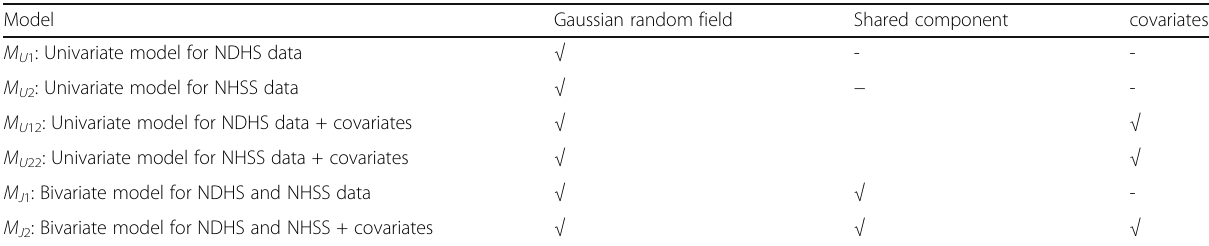
Model Gaussian random field Shared component